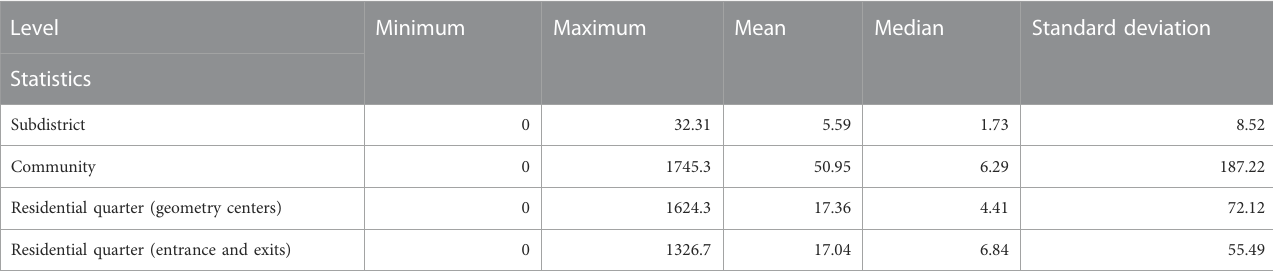
TABLE 1 Accessibility statistics under different research scales (m 2